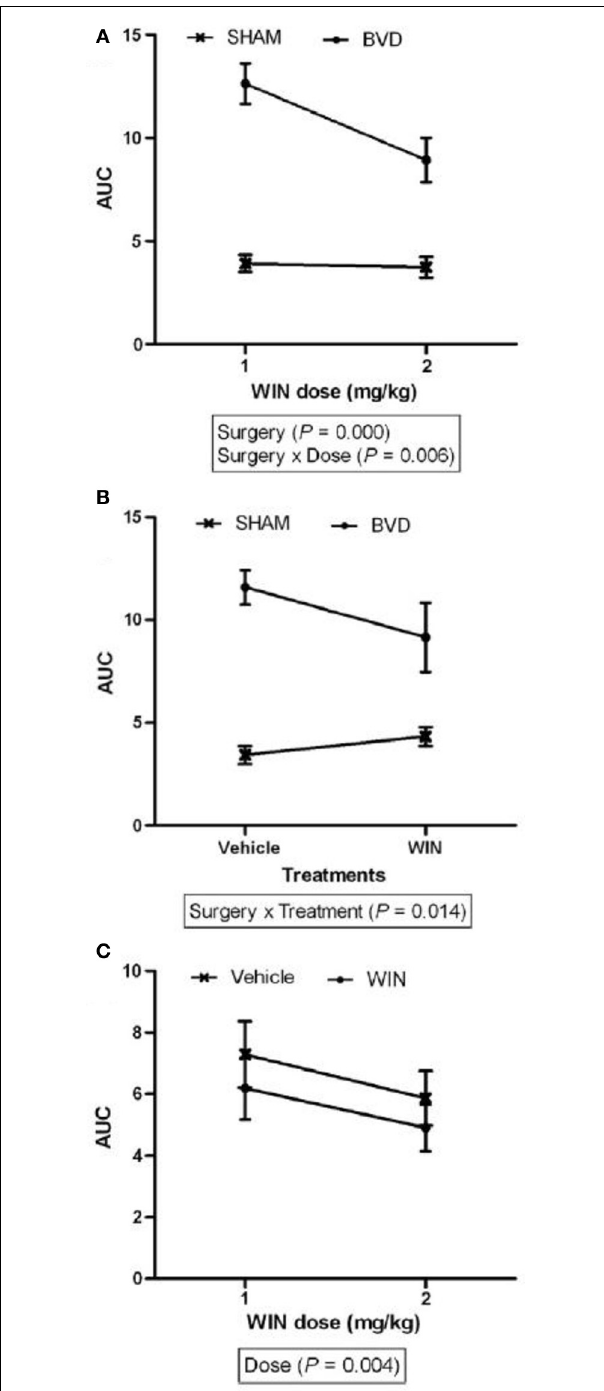
FIGURE 2 | The area under the curve (AUC) for the number of errors exhibited in the same foraging task described in Figure 1, for the sham and BVD animals at 14 month post-op. in darkness, showing the effects of surgery, drug treatment with a cannabinoid receptor agonist, WIN55,212-2 (which one would normally expect to make spatial memory worse), and their interaction. (A) Effects of surgery; (B) Drug treatment; and (C) Drug dose. Data are represented as mean ± s.e.m. Reproduced with permission from Baek et al. (2010).